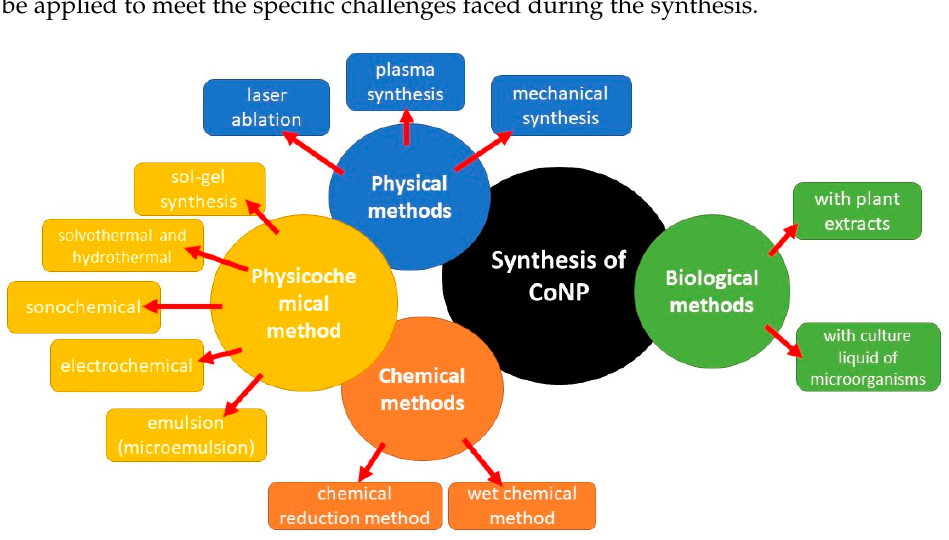
Figure 1. Main methods for the synthesis of cobalt nanoparticles.